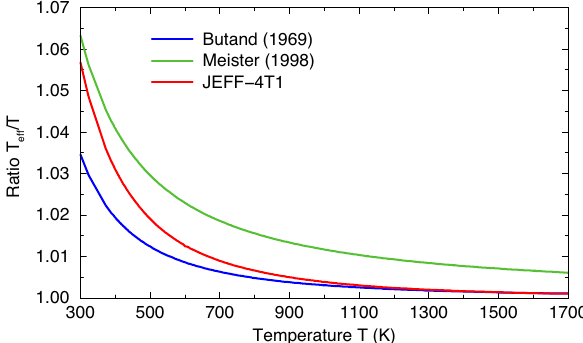
Fig. 3. Ratio T eff /T for 238 U in UO 2 calculated with equa- tions (3), (4) and (1) as a function of T